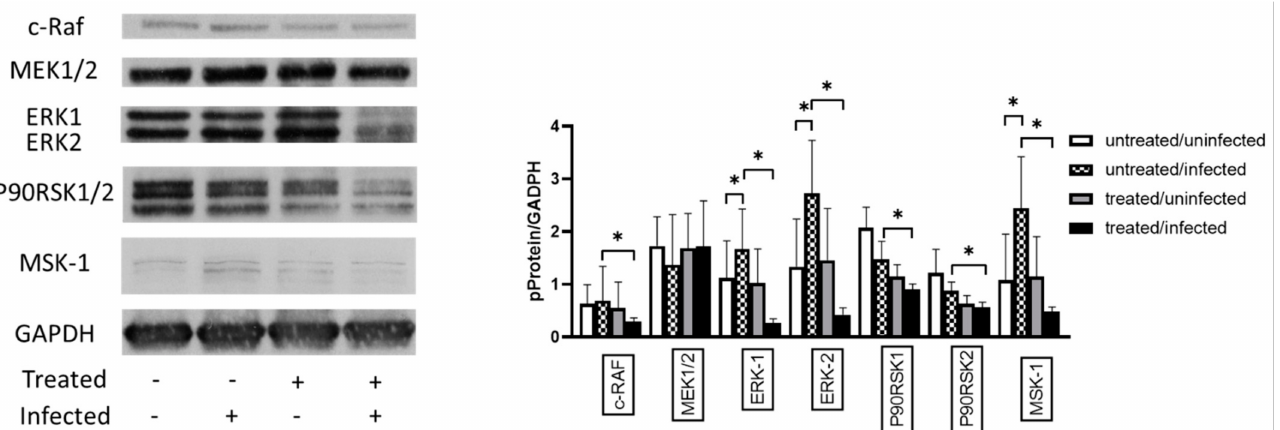
Figure 7. Analysis of the expression of proteins related to the MAPK/ERK pathway. McCoy cells were infected with 0.01 MOI C. pneumoniae , treated with 0.05-mg/mL Ax, infected with 0.01 MOI C. pneumoniae and treated with 0.05-mg/mL Ax, or left untreated. The cells were scraped at 12 h post-infection. Subsequently, proteins in the cell lysates were separated via SDS-PAGE and then blotted onto nitrocellulose membranes. Membranes were incubated with specific primary antibodies against phosphorylated forms of c-RAF, MEK1/2, P90RSK1/2, ERK1/2, MSK-1, and a housekeeping protein/loading control GAPDH. Horseradish–peroxidase-conjugated goat anti-rabbit IgG was used as secondary antibody. Chemiluminescence analysis was performed using the LumiGLO reagent, followed by the exposure of membranes to X-ray films. All films were scanned, and density of the protein bands was quantified using the Quantity One software. The ratio of phosphorylated protein/GAPDH was determined. The results are expressed as the mean ± standard deviation of the data from three independent experiments. The shown Western blot is representative of parallel Western blots (* p < 0.05). MAPK, mitogen- activated protein kinase; ERK, extracellular signal-regulated kinase; c-RAF, RAF proto-oncogene serine/threonine-protein kinase; MEK1, dual specificity mitogen-activated protein kinase; MSK-1, mitogen- and stress-activated protein kinase 1; GAPDH, glyceraldehyde 3-phosphate